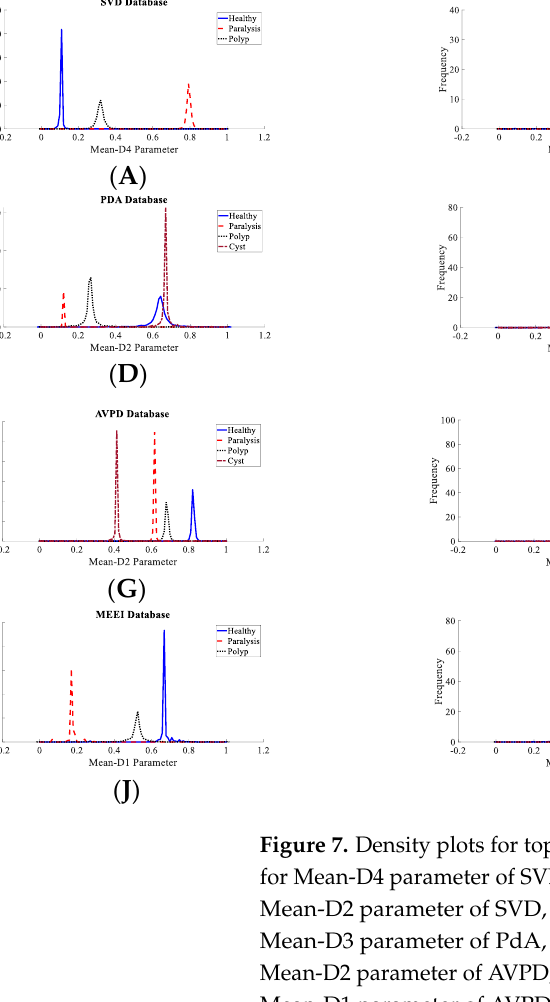
Density plot for Mean-D3 parameter of AVPD, ( H ) Density plot for Mean-D4 parameter of AVPD, ( I ) Density plot for Mean-D2 parameter of AVPD, ( J ) Density plot for Pentropy-A4 parameter of MEEI, ( K ) Density plot for Mean-D4 parameter of MEEI, ( L ) Density plot for Mean-D2 parameter of MEEI.